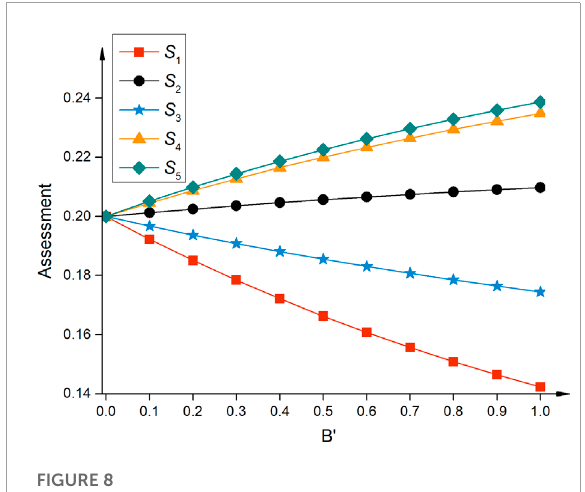
FIGURE 8 Assessment results of alternatives with different component B .